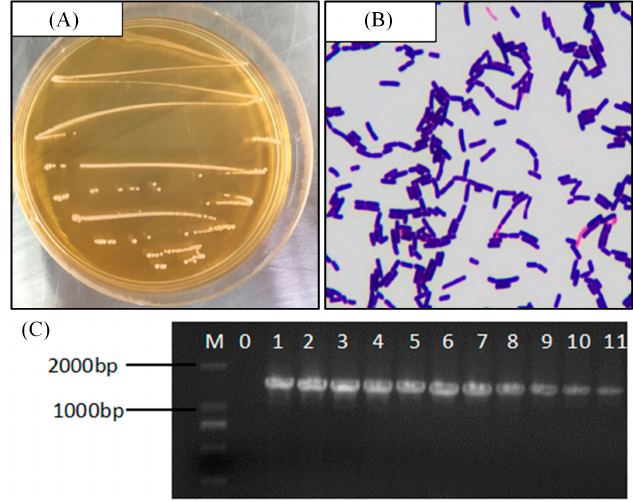
Figure 1. ( A ) Colony morphology, ( B ) Gram staining result, and ( C ) 16S rDNA agarose gel electrophoresis of PCR amplified product of Lactobacillus plantarum CQPC11. M: 2000bp DNA Ladder; 0: negative control group; 11: Lactobacillus plantarum CQPC11.